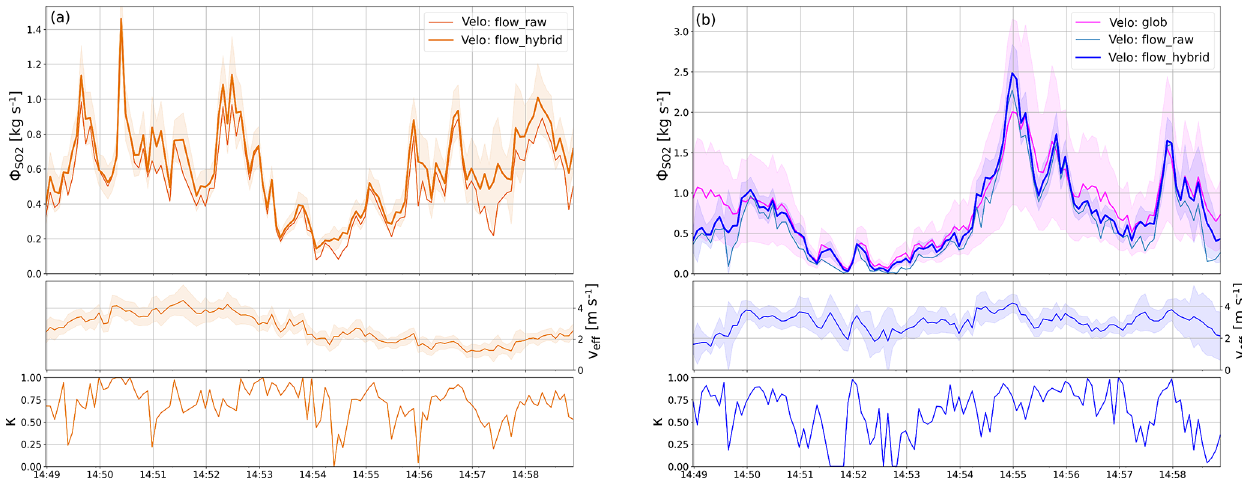
Figure 10. Guallatiri SO 2 emission rates from the summit crater ( a , orange) and the fumarolic field ( b , blue) using the two PCS lines shown in Fig. 2. Uncertainties (shaded areas) are only plotted for the flow_hybrid and the glob (cross-correlation-based) velocity-retrieval methods. Also included are the corresponding effective velocities (from the flow_hybrid method) and the OF quality factors κ (Eq. 7). The central crater emissions show only little variability ( (cid:56) ≈ 0 . 6kgs − 1 ), while the fumarolic emissions are characterised by a comparatively strong emission event at 14:55UTC showing peak emissions of 2 . 5kgs − 1 .